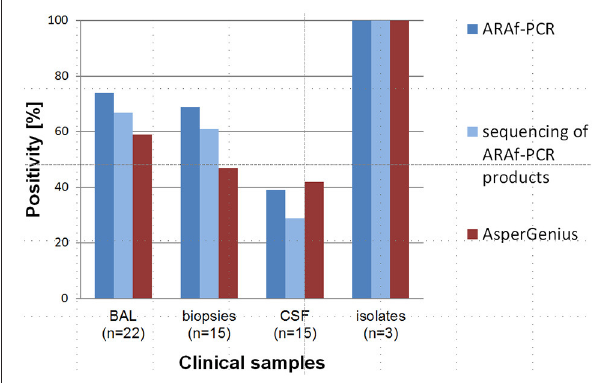
FIGURE 3 | Comparison of diagnostic results of our ARAf PCR assays and the AsperGenius ® system concerning the detection of A. fumigatus DNA directly from clinical samples as a prerequisite for the characterization of triazole resistance mutations. ARAf PCR results are shown in the dark blue bars, positive ARAf PCR sequencing is shown in light blue bars; the red bars show the AsperGenius ® PCR results. In BAL samples the positivity of the ARAf PCRs plus sequencing was slightly higher (8%). In biopsy samples the ARAf PCRs assays plus sequencing showed a 14% higher positivity. Results